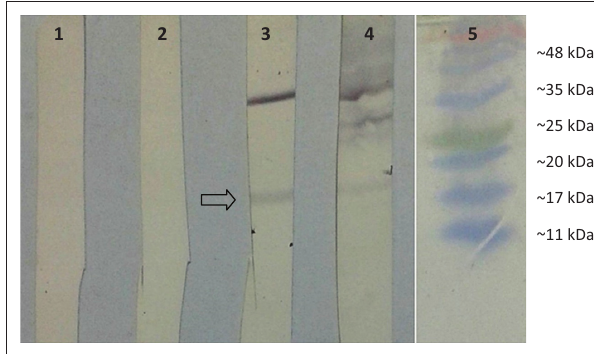
FIGURE 2: Verification of anti-G1 antibodies against pcDNA3.1-G1 and bovine ephemeral fever (BEF)-inactivated vaccine in reaction to the 18-kDa G1 protein using immunoblotting. Lanes 1–4, respectively, show the membrane strips exposed to serum of inoculated mice with phosphate-buffered saline (1X), pcDNA3.1, pcDNA3.1-G1 and BEF-inactivated vaccine; Lane 5 shows the marker